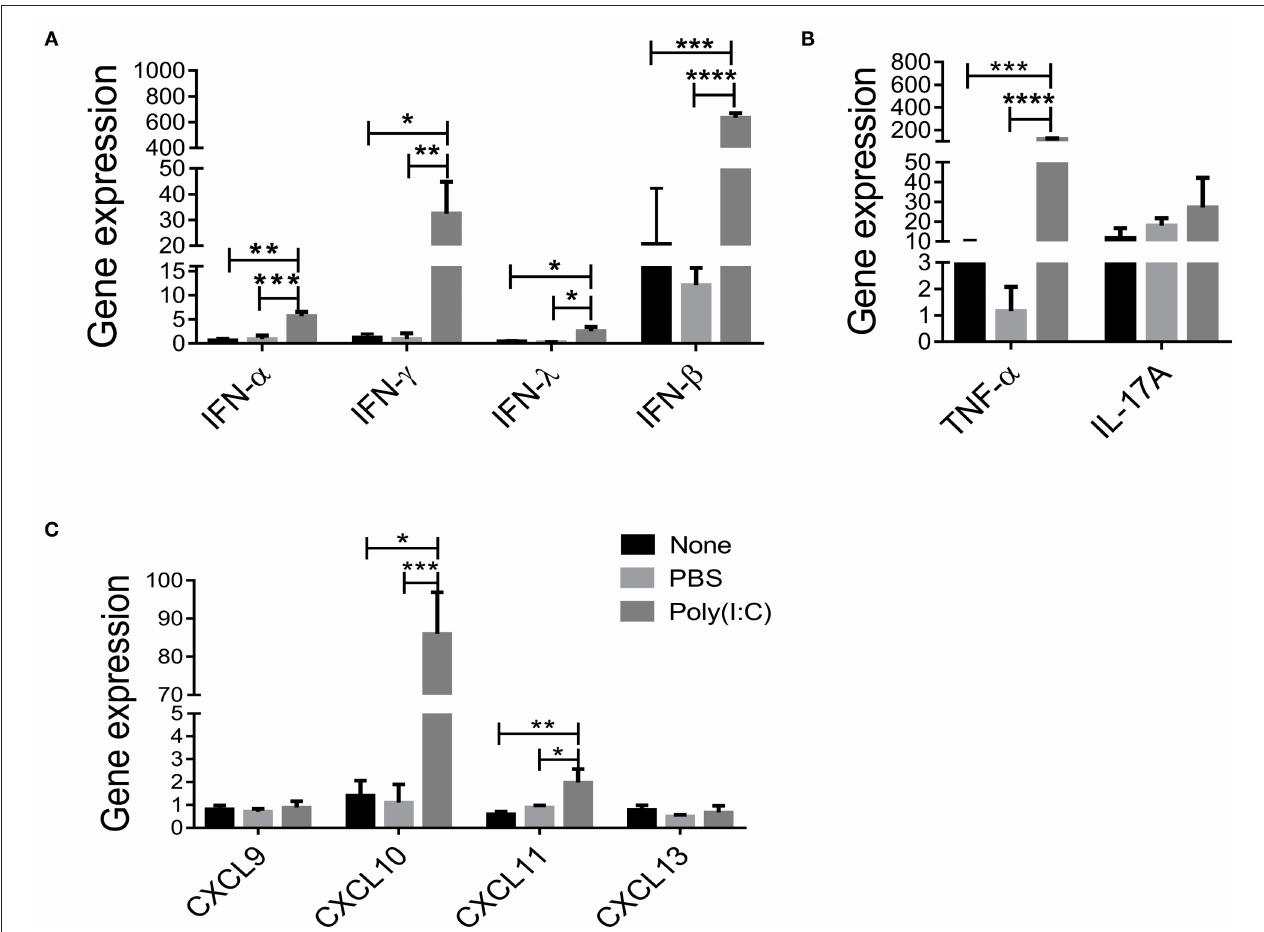
FIGURE 3 | Poly(I:C) treatment increased IFN cytokines and T cell chemokines levels in salivary gland. (A) The mRNA levels of IFN (IFN- α , IFN- β , IFN- γ , IFN- λ ) were determined by real-time PCR ( n = 5, 5, 4). (B) The mRNA levels of T cell associated cytokines were determined by real-time PCR, TNF- α (Th1 cytokine) and IL-17A (Th17 cytokine). (C) The mRNA levels of CXCL9, CXCL10, CXCL11 and CXCL13 in salivary gland. Data were presented as mean ± SEM, * p < 0.05, ** p < 0.01, *** p < 0.001, and **** p <